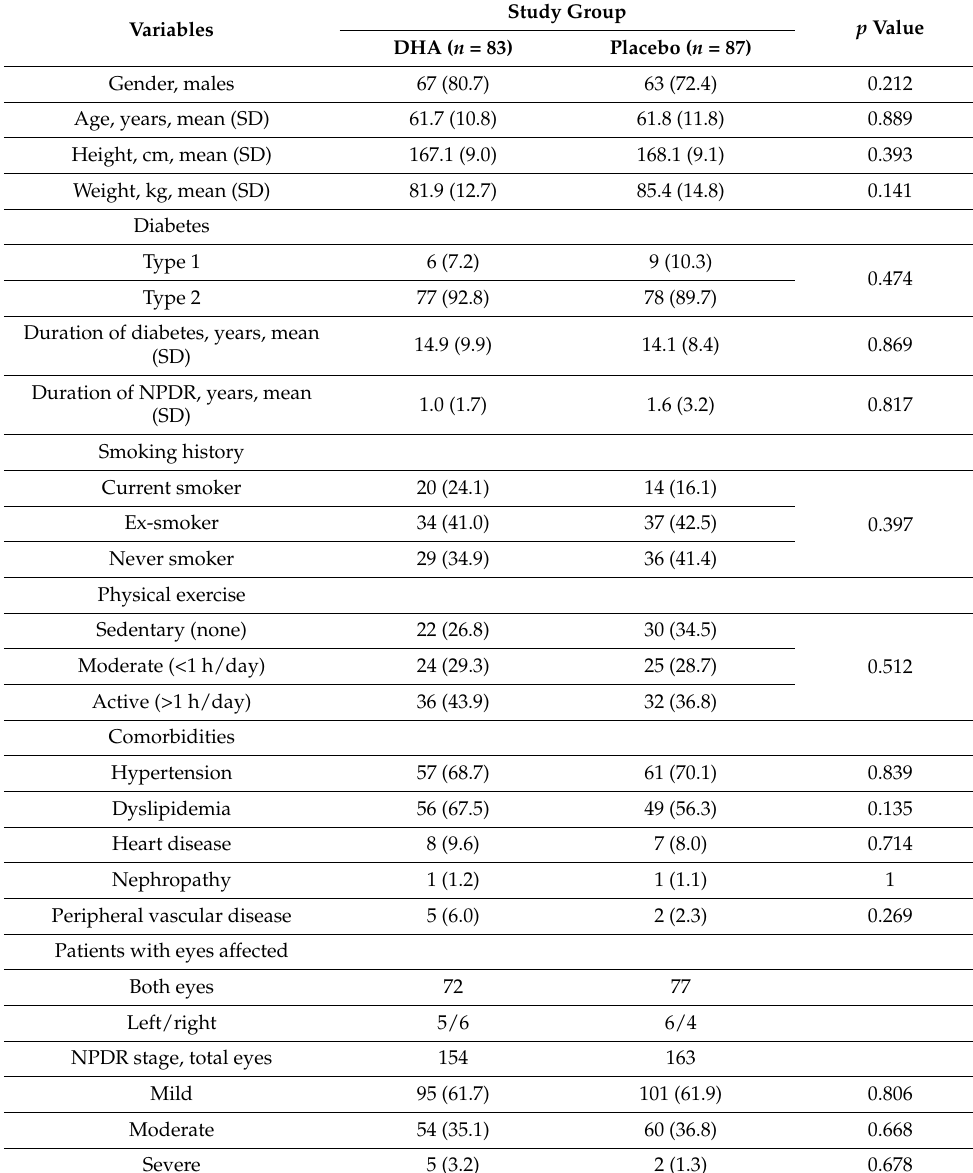
Table 2. Demographic and clinical characteristics of the study